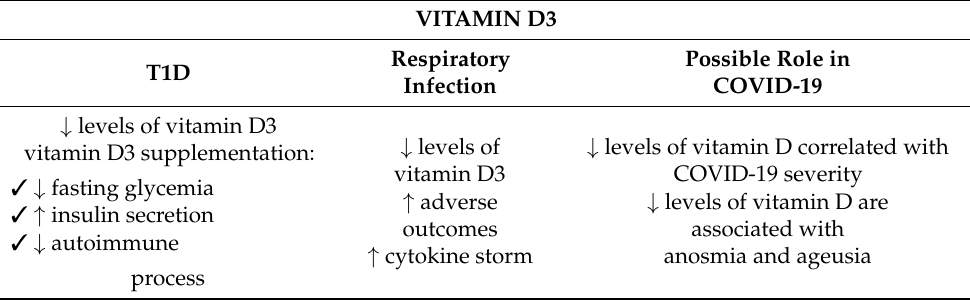
Table 1. Evidence related to low levels of vitamin D in T1D, respiratory infection and its putative association with COVID-19.